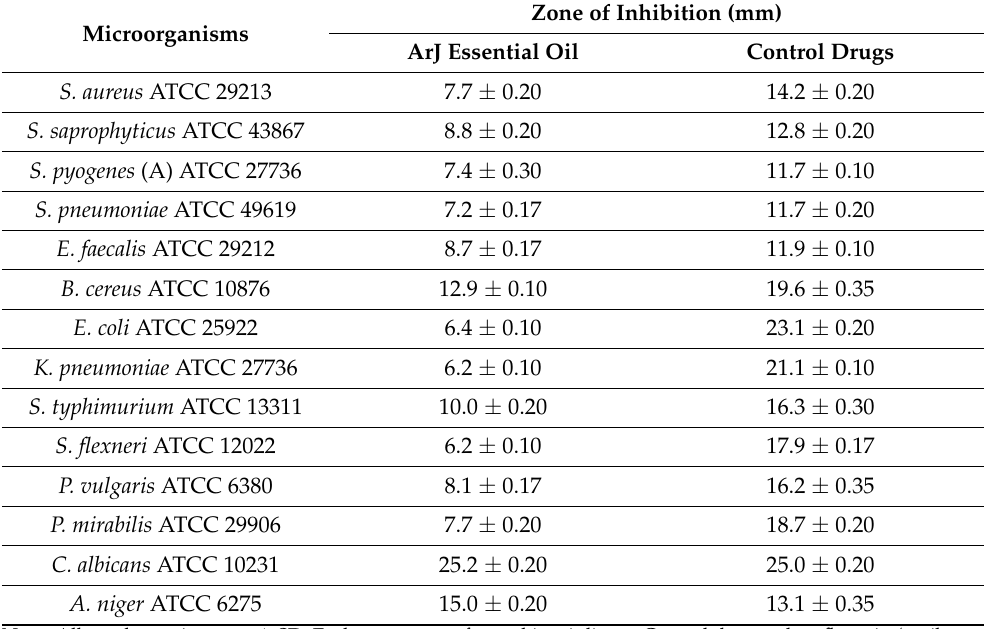
Table 3. Preliminary antimicrobial activity of ArJ essential